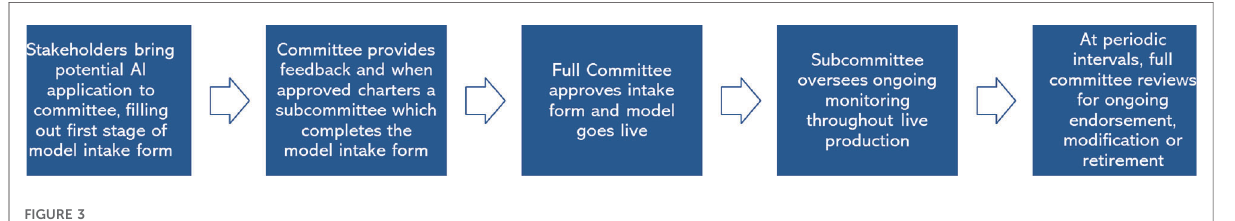
FIGURE 3 UW Health predictive model value